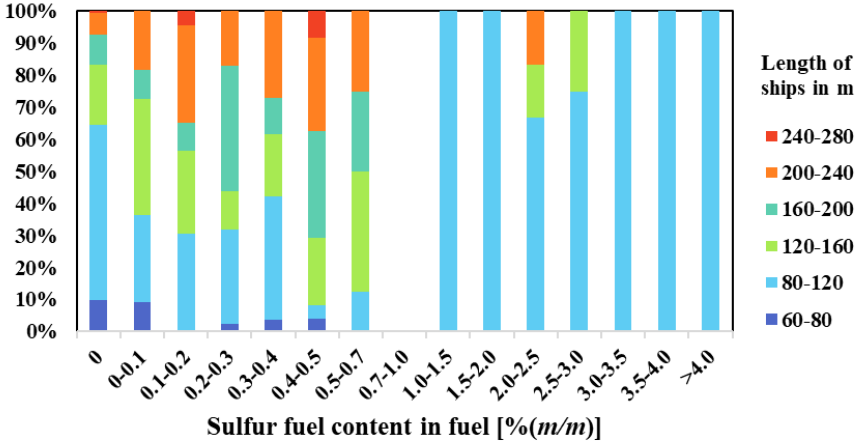
Figure 5. Comparison of compliance levels between ship lengths.